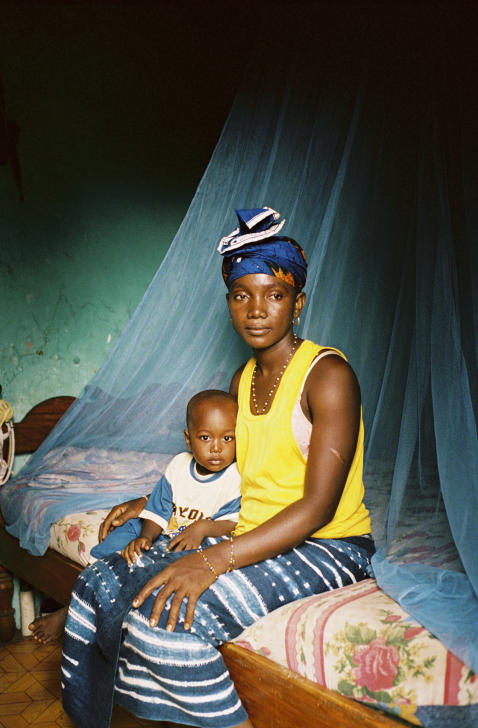
Bed nets are essential in malaria-endemic regions such as The Gambia